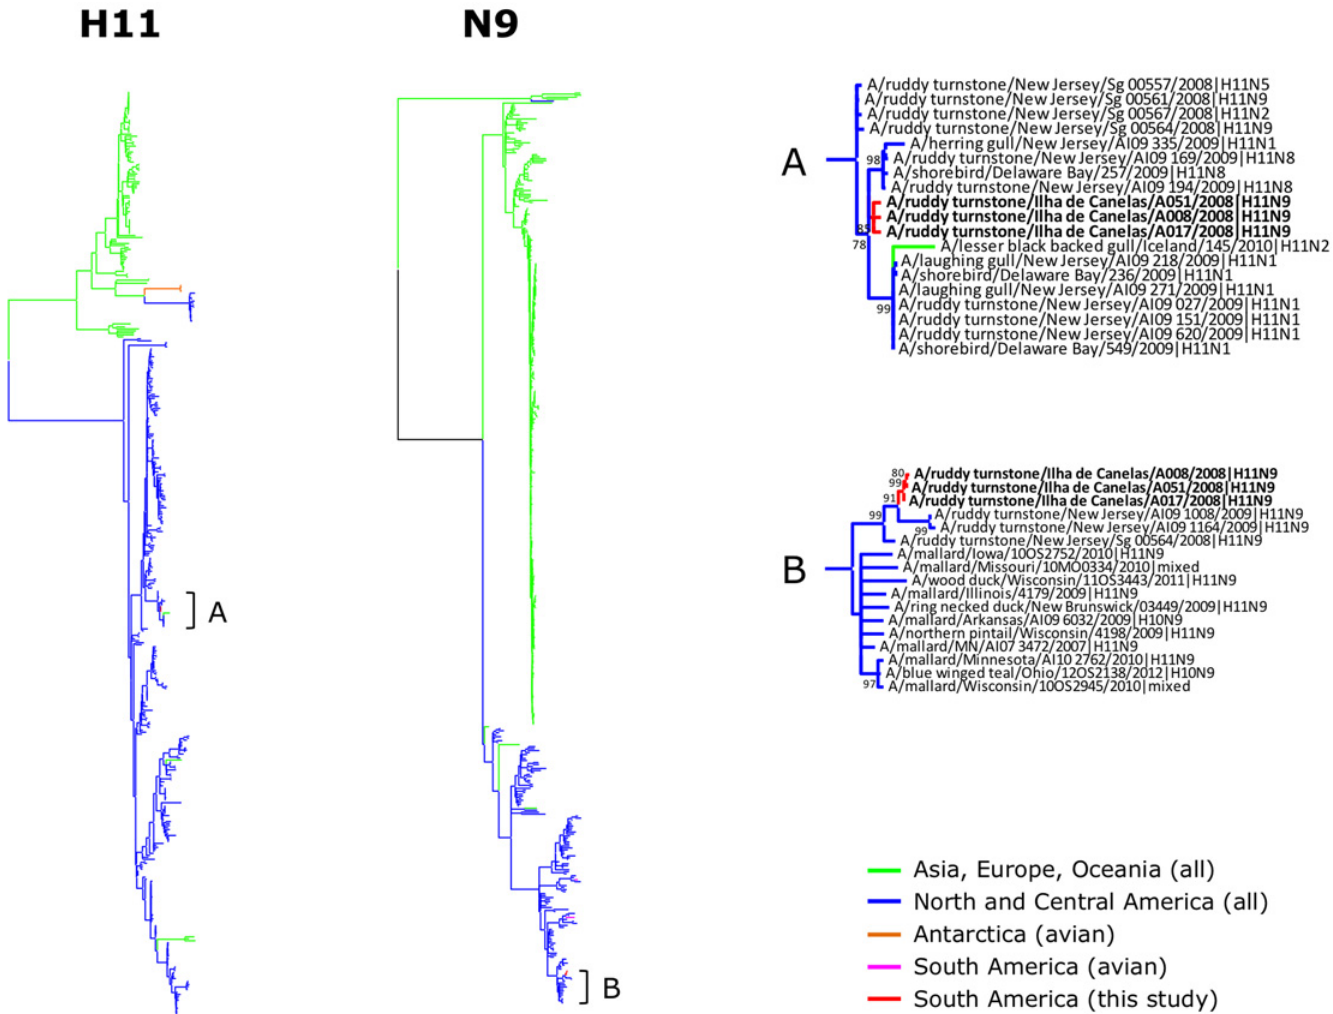
Fig 2. Phylogenetic tree of H11 and N9 sequences. Trees are drawn to the similar scales, with branch lengths proportional to evolutionary distance. Bootstrap values lower than 30 are